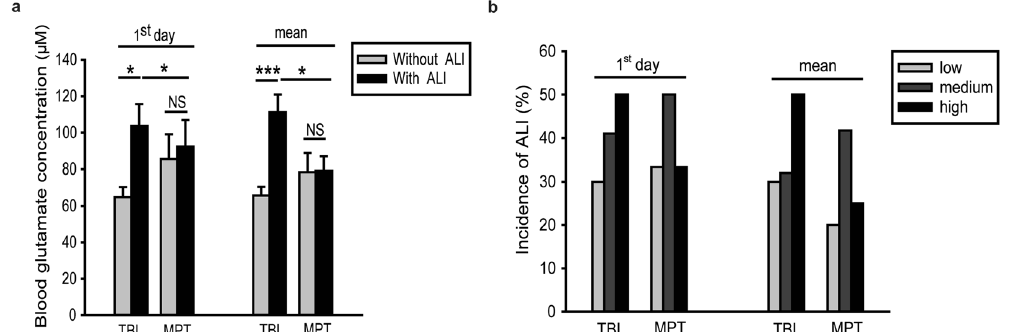
Figure 2. ( a ) Comparison of glutamate concentrations between subgroups (with or without ALI) of patients with TBI or MPT. Data are expressed as the means ± SE. ( b ) Incidence of ALI according to different blood glutamate levels in patients with TBI or MPT. * p < 0.05 and *** p < 0.001 for comparisons between the two groups using two-tailed Student’s t -tests or nonparametric Mann-Whitney U tests; NS, not significant. MPT, multiple peripheral trauma; TBI, traumatic brain